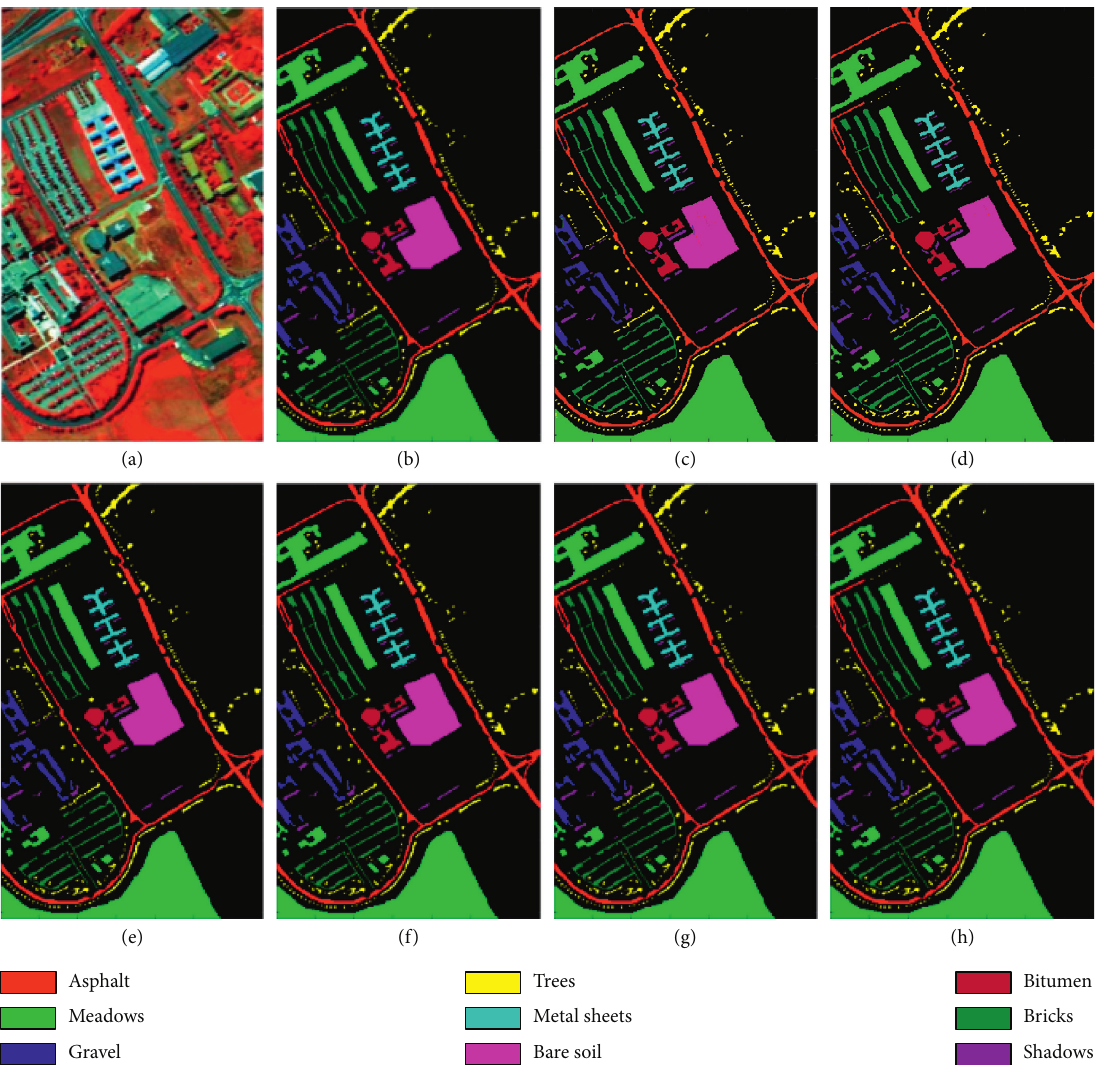
Figure 13: Classification maps for the IN dataset. (a) False color image, (b) ground truth, and (c)-(h) predicted classification maps for SVM- RBF, 2D CNN, 3D CNN, SSRN, HybridSN, and proposed